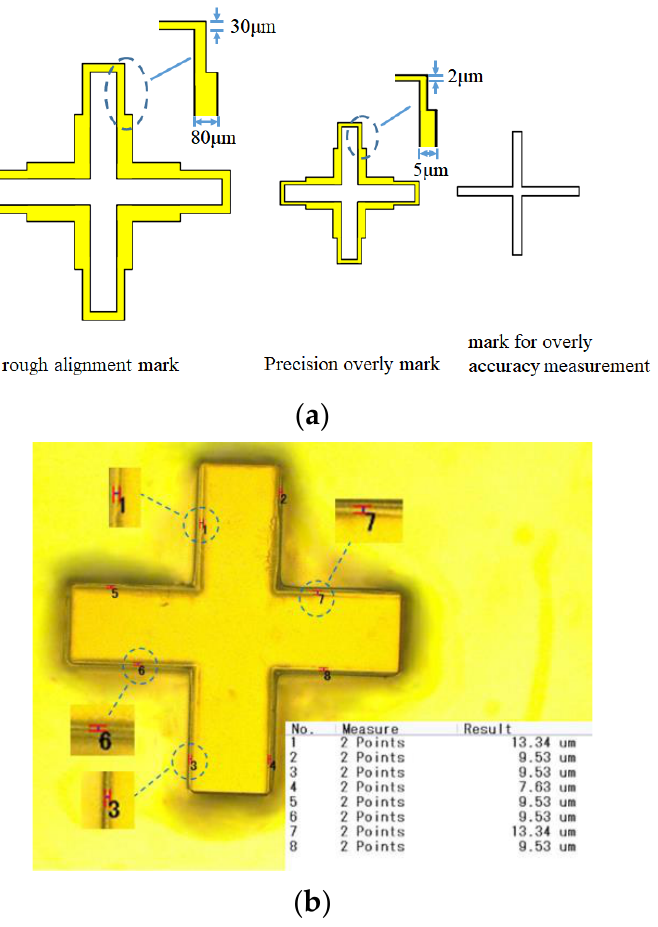
Figure 8. Multi-layer overlay marking ( a ) Design of the engraved marks and measured marks for masks ( b ) Precision measurement of overlays, and the maximum tolerance is 13.34 μm.